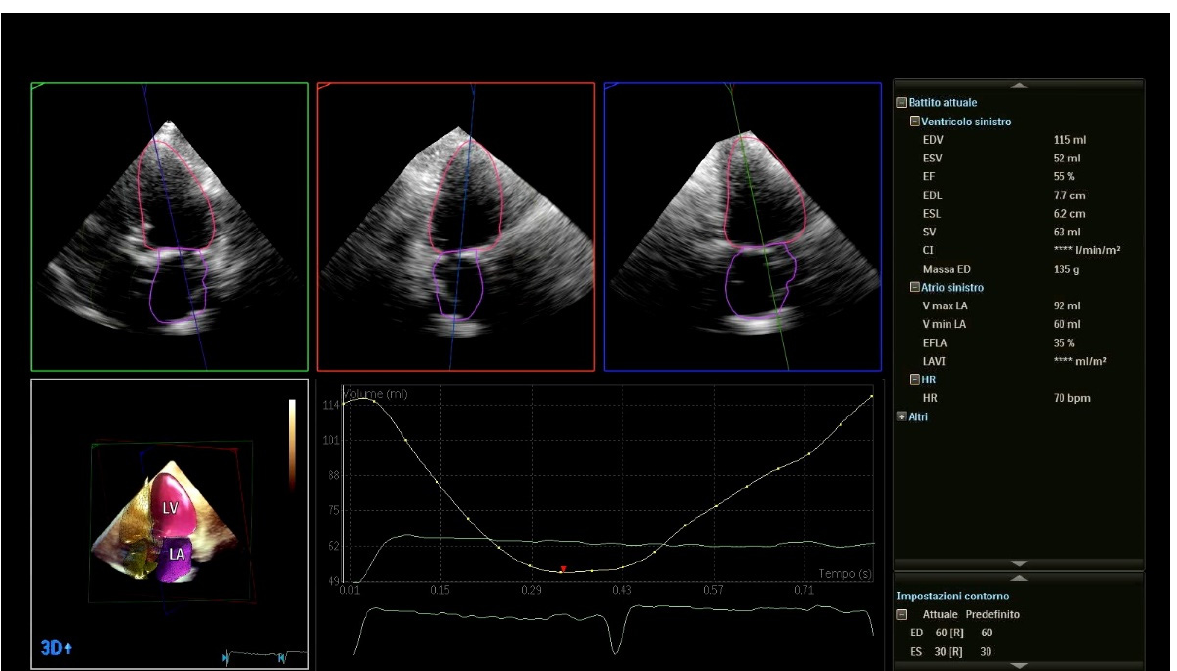
Figure 3. Three-dimensional measurements (LV volumes) obtained from automated DHM in the same patient. This advanced echocardiography allows for accurate, automated measurements of chamber volumes and function, providing larger and more accurate LV volumes with good agreement with cardiac magnetic resonance when analyzed using the default settings of the boundary detection sliders (end-diastolic default position = 60/60; end-systolic default position = 30/30). The calculated Rvol = SVLV – SVForward = 63 − 40 mL = 20 mL. EROA = Rvol/VTIRegJet = 20/186 = 0.10 cm 2 . LV: left ventricular; DHM: Dynamic Heart Model, Philips Healthcare, Andover, MA, USA; Rvol: regurgitant volume; SVLV: stroke volume ejected by the left ventricle; SVForward: forward stroke volume. 2D: bi-dimensional echocardiography; PISA: proximal isovelocity surface area; 3D: three-dimensional echocardiography; MR: mitral regurgitation; EROA: effective regurgitant orifice area.